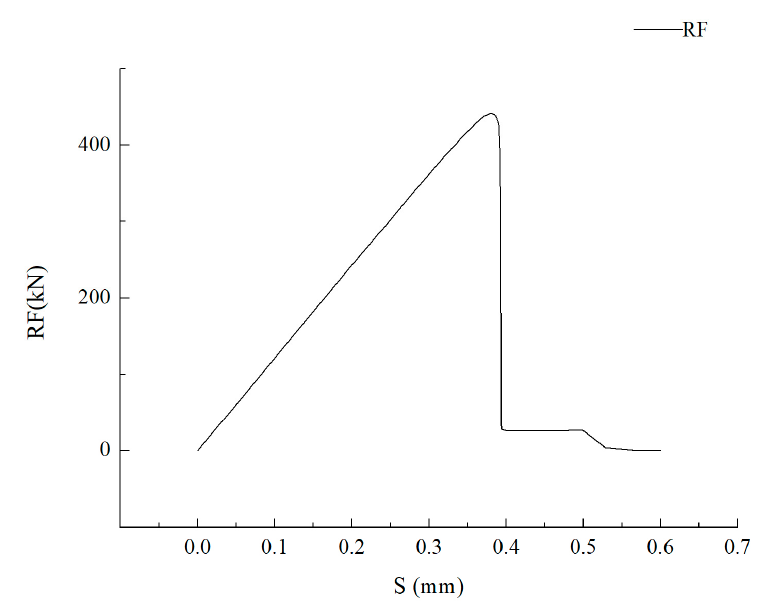
Figure 12. The relation of the reaction force of tensile model with displacement load.